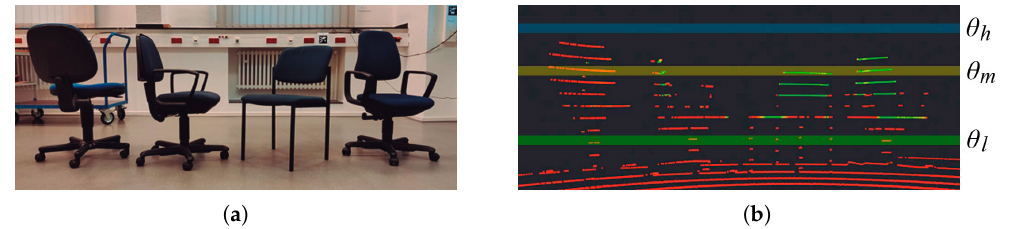
Figure 7. Angle segmentation: ( a ) real scenario with different models of chairs; ( b ) point-cloud with θ l , θ m and θ h